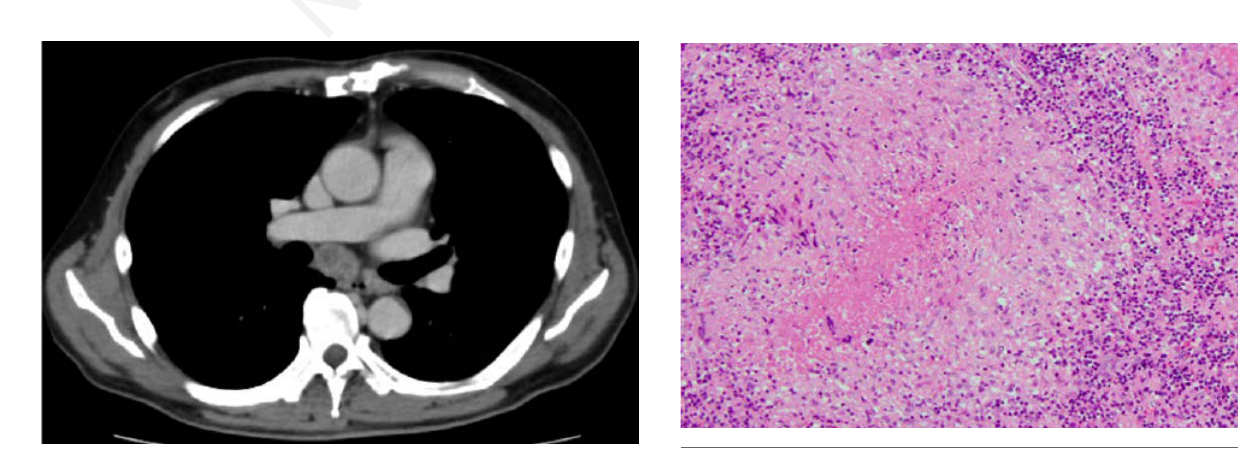
Figure 1. Enhanced computed tomography revealed mediastinal lymphadenopathy.